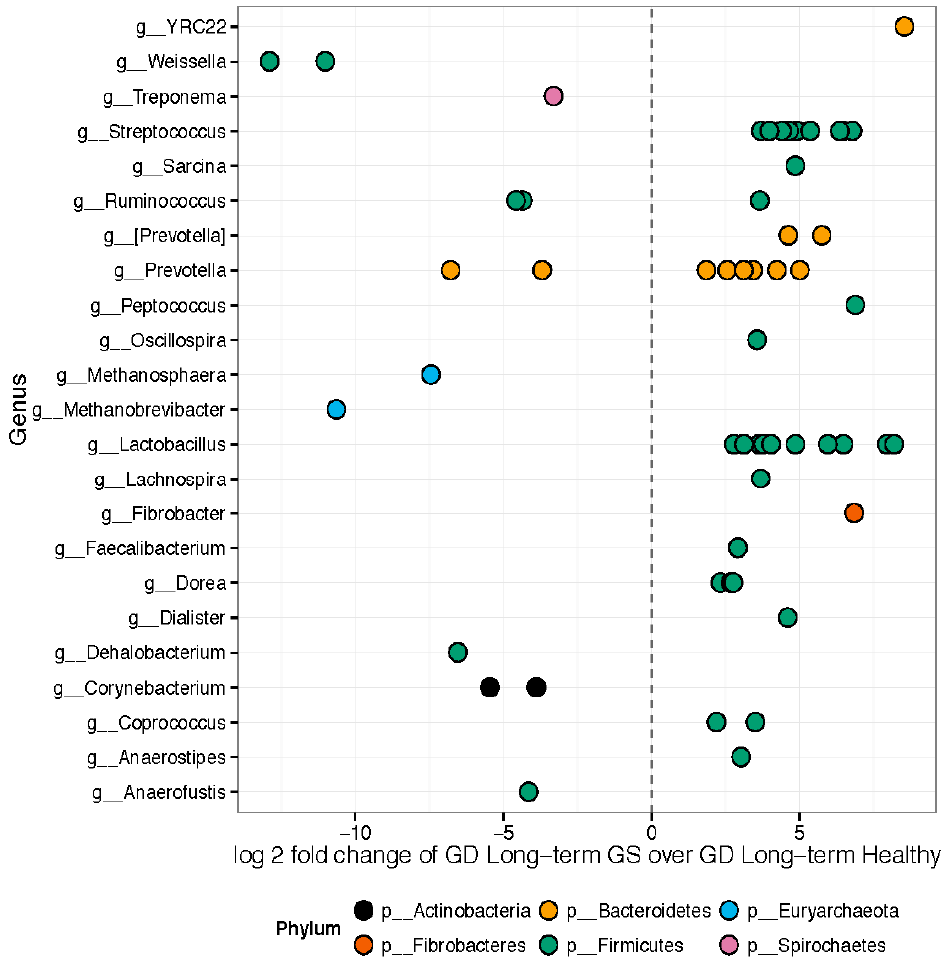
Figure 3. Differentially abundant features: GS macaques vs. healthy controls on GD. Each point represents an OTU belonging to each Genus. Only significant OTUs assigned at genus-level are shown. Features were considered significant if their FDR-corrected p -value was less than or equal to 0.05. There were 157 significantly different OTUs detected out of 1263 tested. Fifty-six OTUs had genus-level annotations.